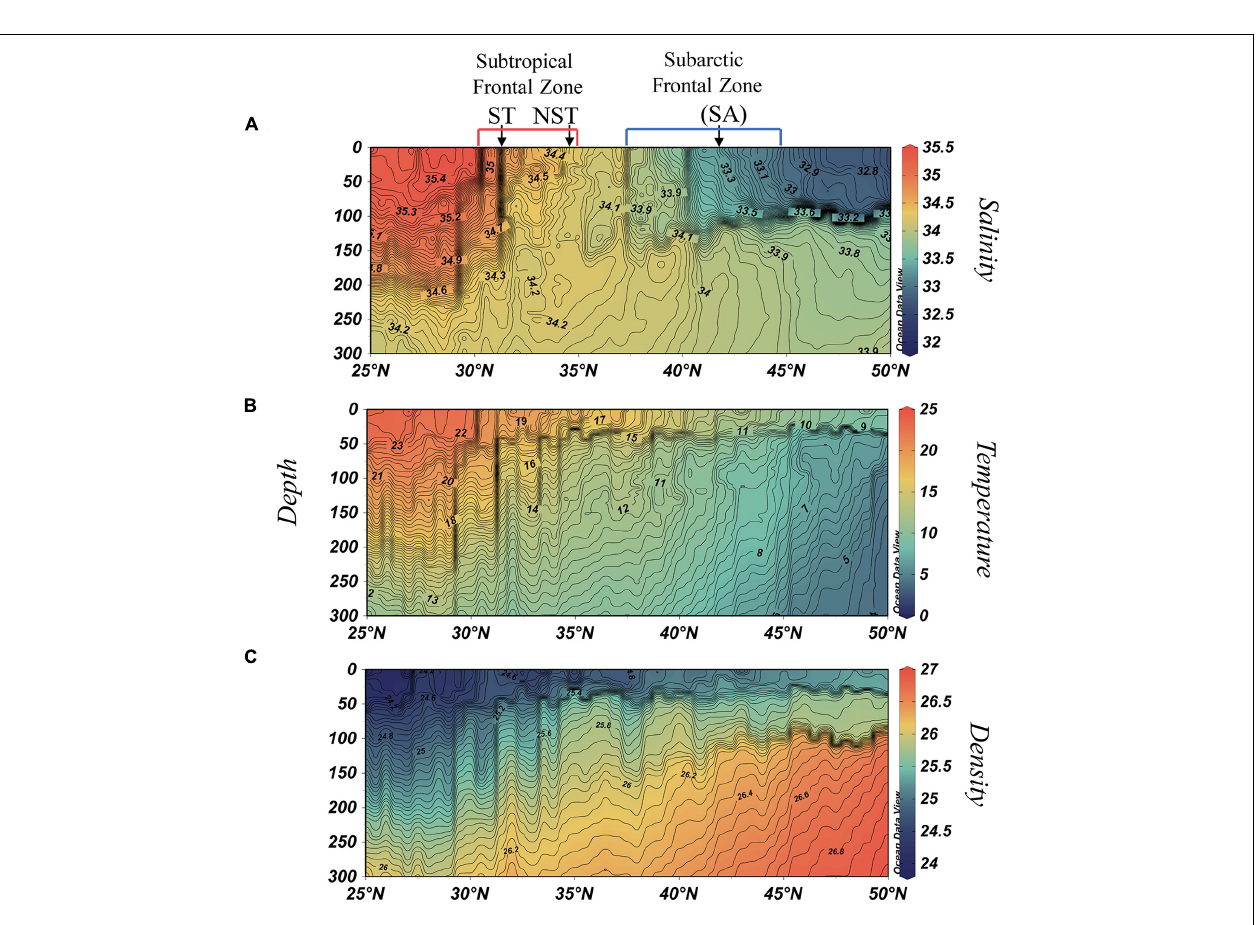
Frontiers in Marine Science |